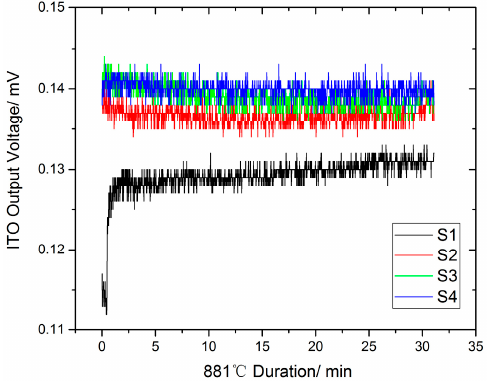
Figure 12. Heat cycle results.